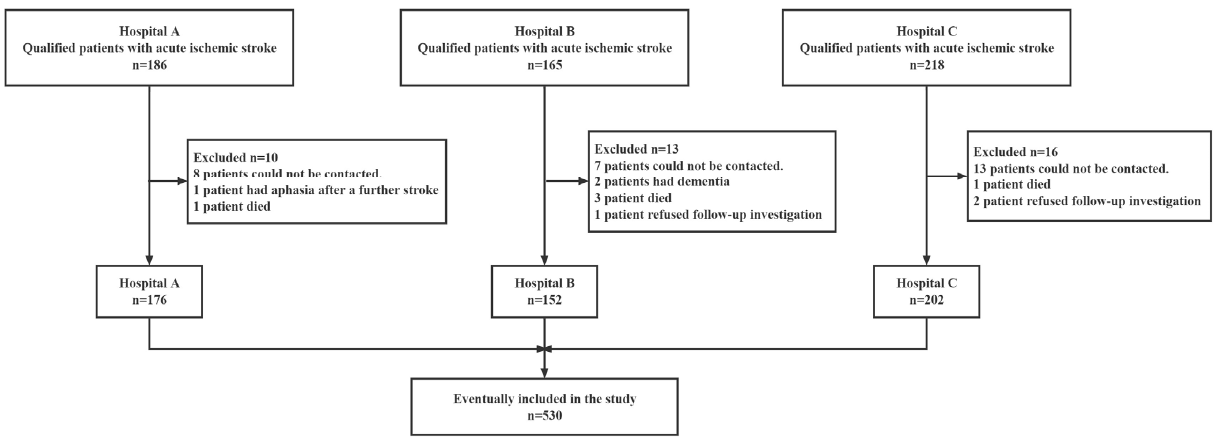
Figure 1. Flowchart of participant enrollment .